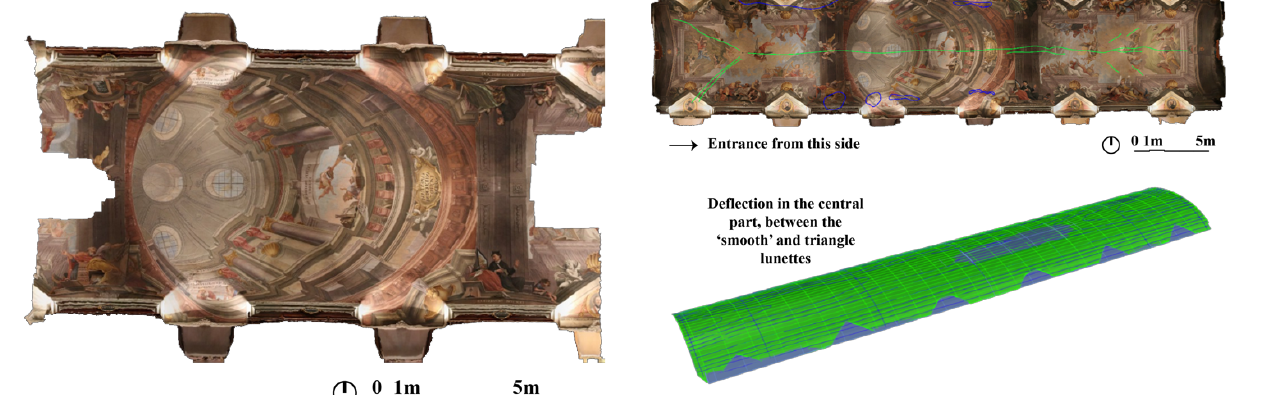
Figure 6. Crack patterns (green) and water leakages (blue) (top) and deflection analysis (bottom) of the Klementinum Baroque Library